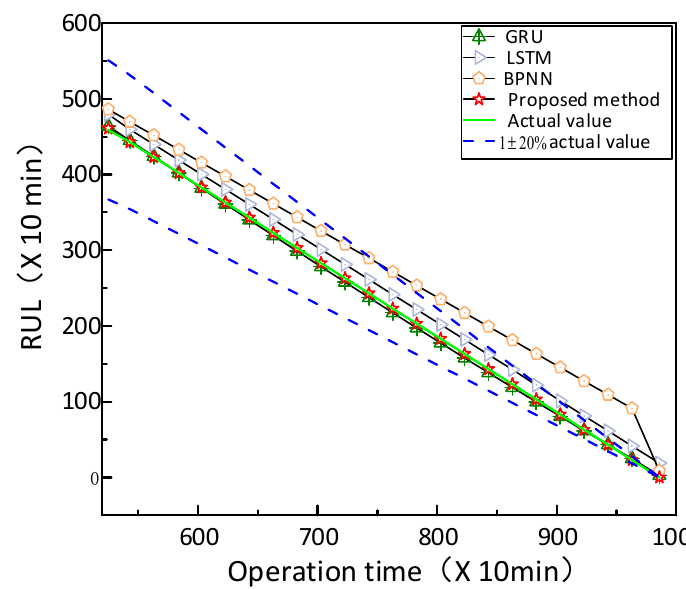
ff erent methods.